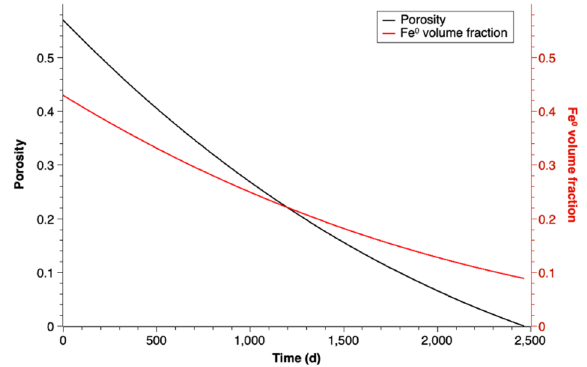
Figure 7. Porosity and Fe 0 volume fraction versus time assuming goethite as reaction product.